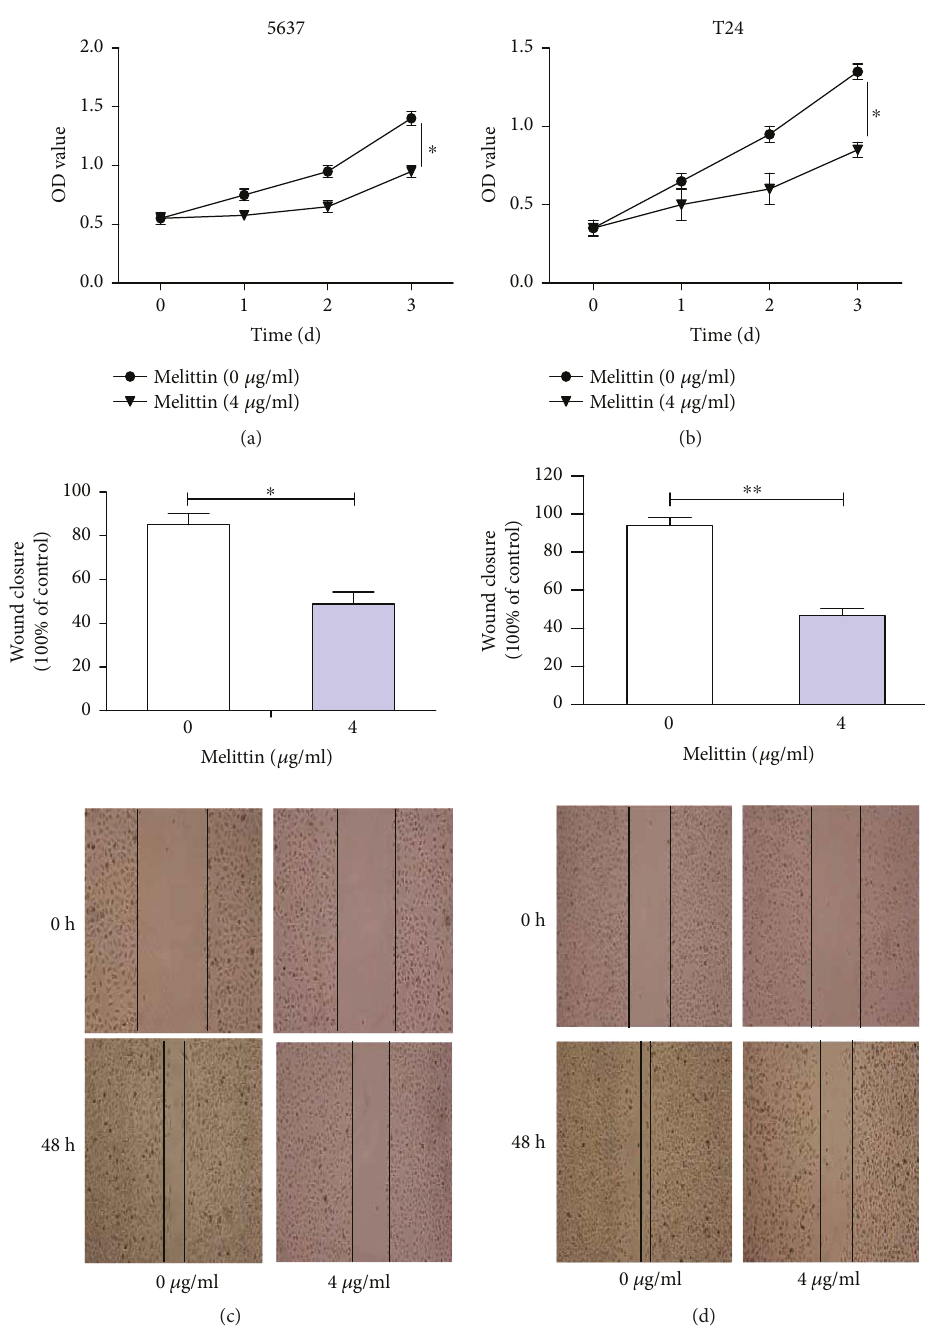
Figure 7: Melittin suppressed cell proliferation and migration in 5637 and T24 cell lines. (a) 5637 and (b) T24 cell viabilities were signi fi cantly inhibited in the melittin-treated group (4 μ g/ml) in comparison with the control group (0 μ g/ml) as determined by the MTS assay. (c) 5637 and (d) T24 cell migration was remarkably constrained in the melittin-treated group (4 μ g/ml) in comparison with the control group (0 μ g/ml) as analyzed by the scratch wound-healing assay. Magni fi cation × 100. OD: optical density. ∗ P < 0 05 and ∗∗ P < 0 01